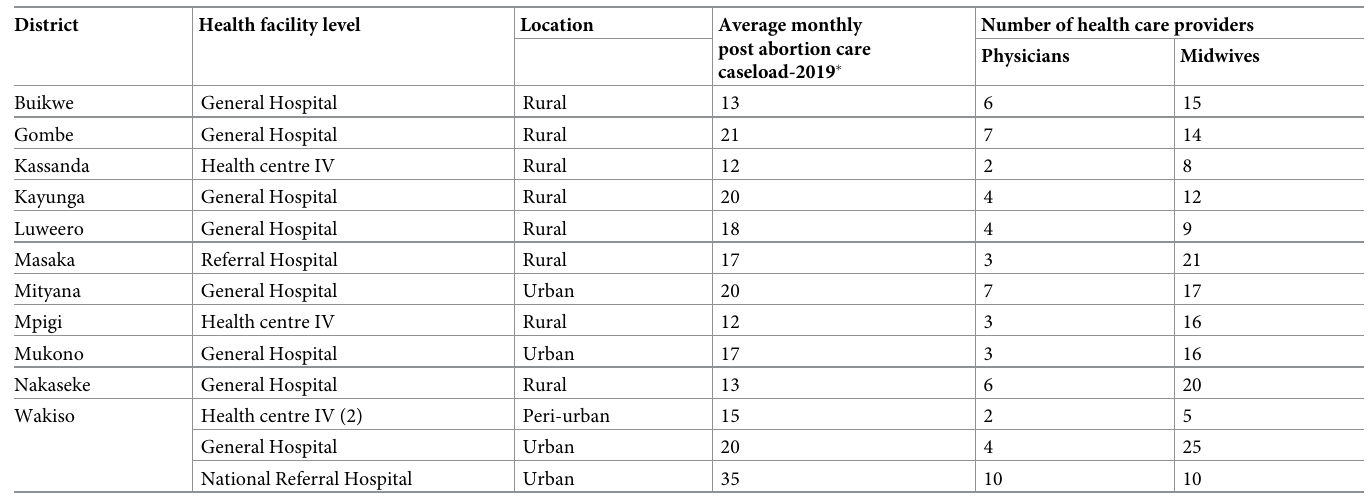
Table 1. Characteristics of participating public health